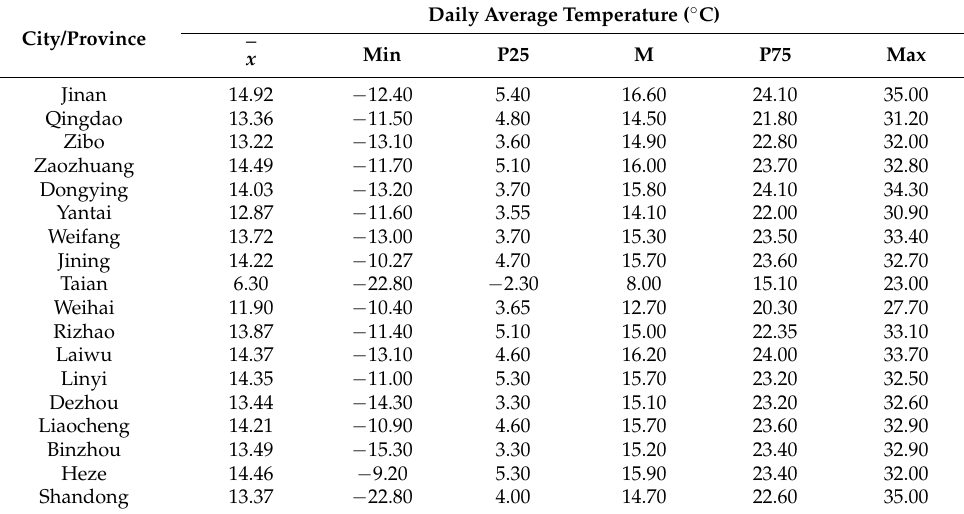
Note: Min, P25, M, P75, and Max represent the minimum, 25th percentile, median, 75th percentile, and maximum value,